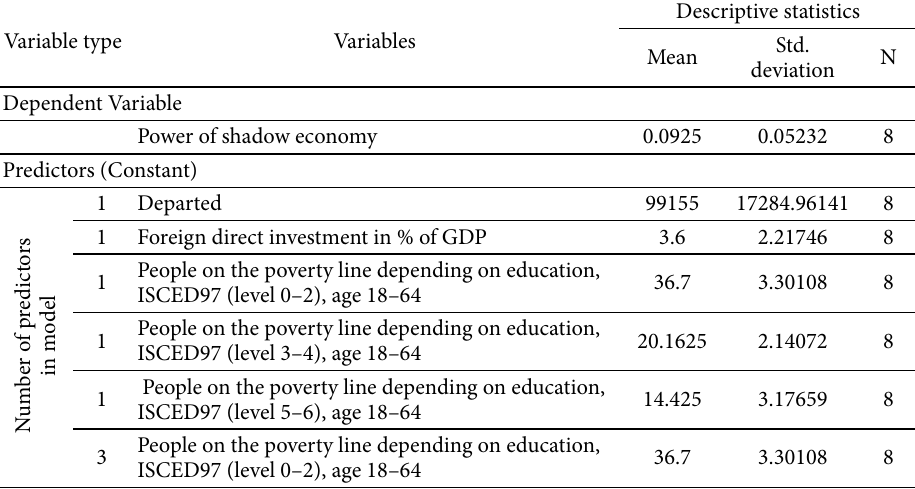
Table 12. Descriptive statistics in estimation of the interdependence between shadow economy power and human capital variables for the period of 2005–2012 Variable